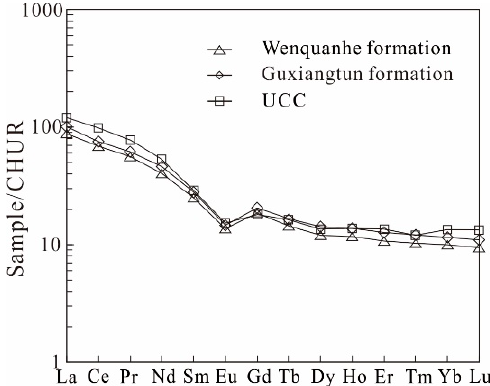
Figure 5. Chondrite normalized rare earth element patterns of sediments from the Songhua River [33].